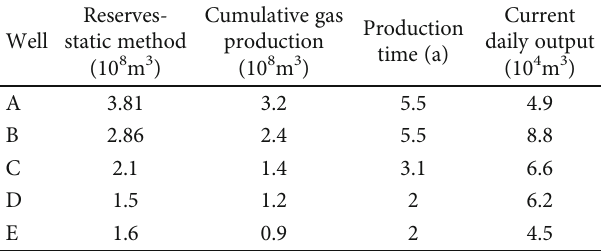
Table 4: Gas production of typical wells in the Fuling shale gas fi